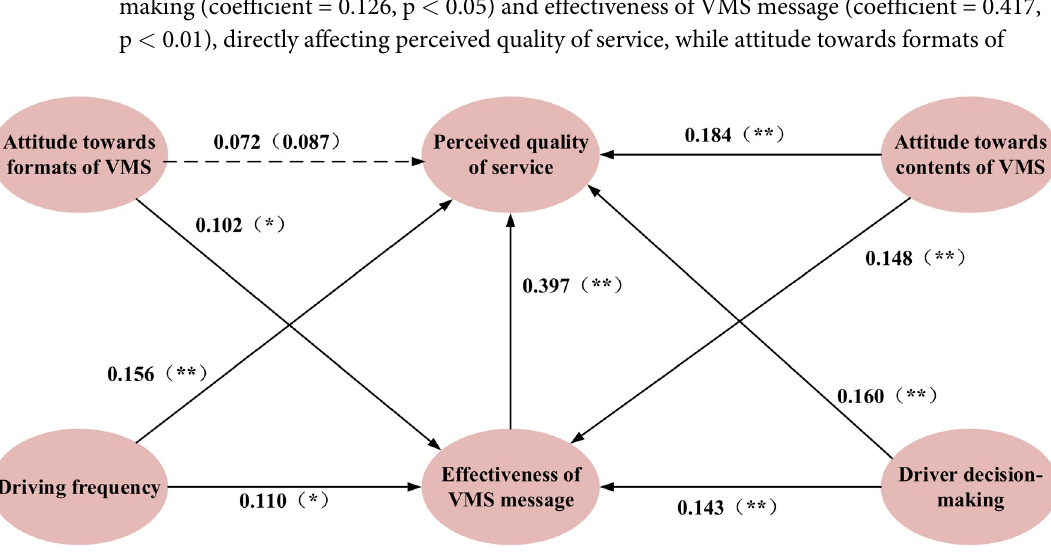
Fig 5. Estimated results of MIMIC for private car drivers (Model I). Notes: Coefficients are statistically significant at the 5% level ( � p < 0.05, �� p <